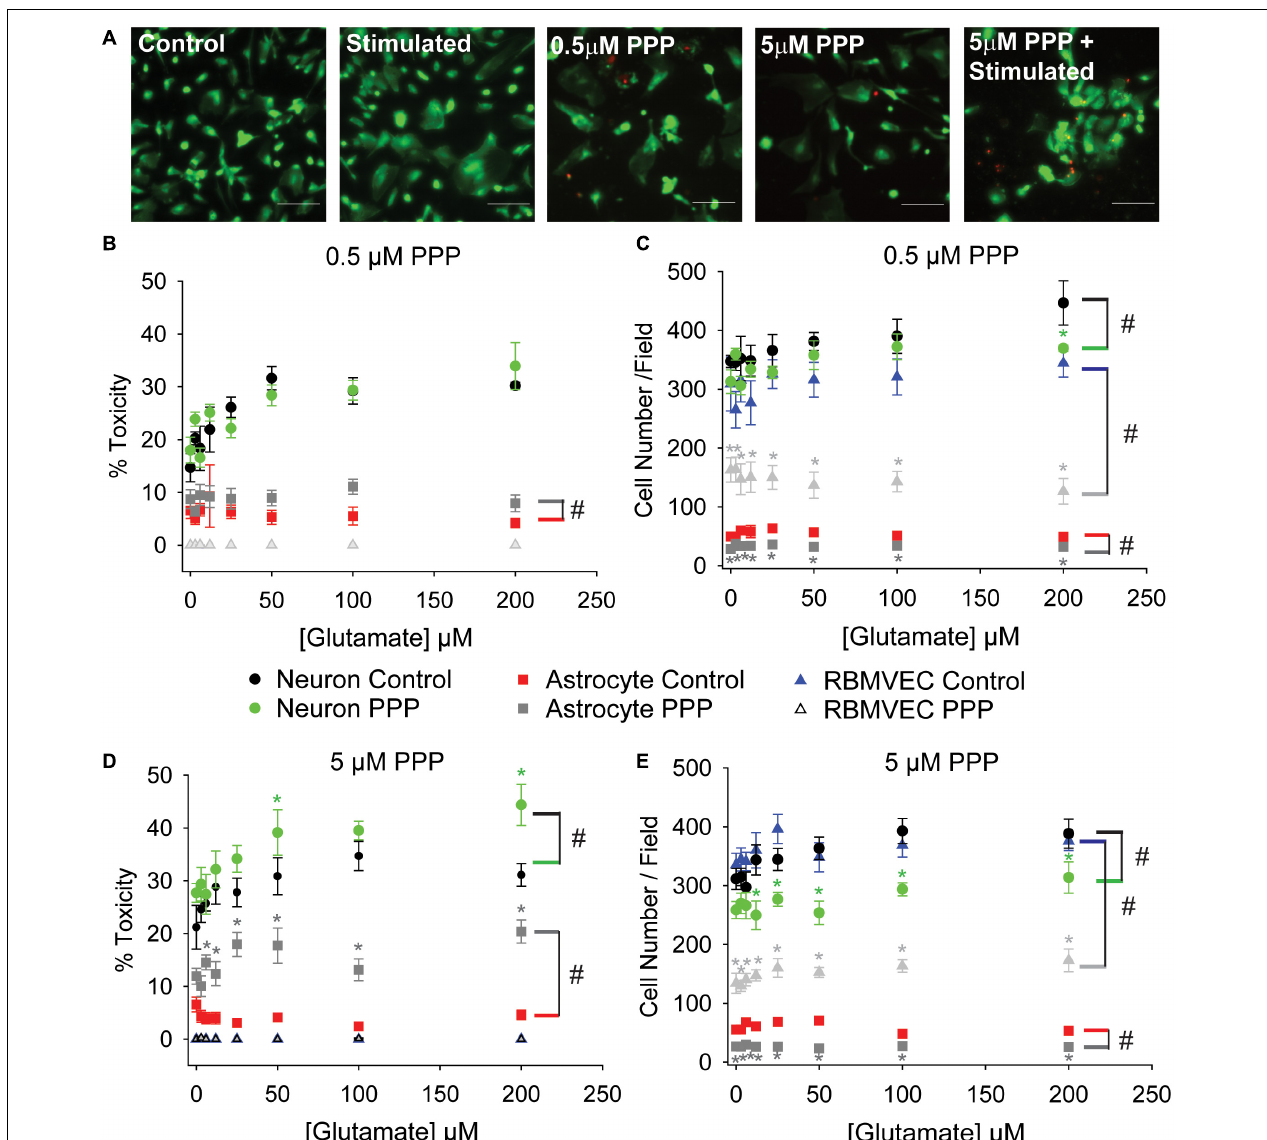
FIGURE 2 | Prolonged IGFR inhibition increases astrocytic sensitivity to glutamate and reduces astrocyte and endothelial cell number. (A) Representative images of astrocytes stained with live (green)/Dead (red) viability/cytotoxicity indicator dyes. From left to right: unstimulated control, glutamate-stimulated vehicle-treated, unstimulated 0.5 µ M PPP-treated, unstimulated 5 µ M PPP, and glutamate-stimulated 5 µ M PPP. Scale bar represents 100 µ m. (B) Average toxicity and (C) average cell number per well of cells pre-treated with 0.5 µ M PPP, and subsequently stimulated with increasing concentrations of glutamate, 24 h after stimulation. (D) Average toxicity and (E) average cell number per well of cells pre-treated with 5 µ M PPP, and subsequently stimulated with increasing concentrations of glutamate, 24 h after stimulation. All data are presented as mean ± SEM, n = 5–8 wells/treatment group. A two-way ANOVA was employed with glutamate concentrations and PPP-treatment serving as factors. Cell types were each analyzed independently. # indicates a significant main effect within that cell type. Post hoc Holm-Sidak tests were used for pairwise multiple comparisons. *indicates a significant difference between PPP-treatment and vehicle-treatment within a given glutamate concentration. Graph color code: black circles = vehicle-treated neurons; green circles = PPP-treated neurons; red boxes = vehicle-treated astrocytes; dark gray boxes = PPP-treated astrocytes; blue triangles = vehicle-treated rat brain microvascular endothelial cells (RBMVEC); and light gray triangles = PPP-treated